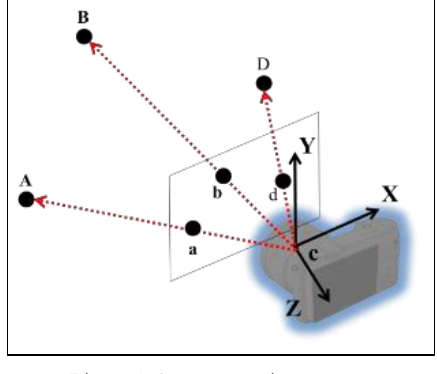
Figure 4. Space resection concept